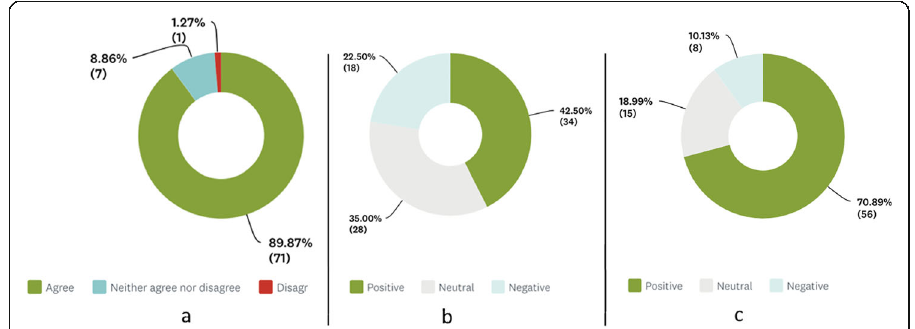
Fig. 8 a – c The importance of corporeal dispositions